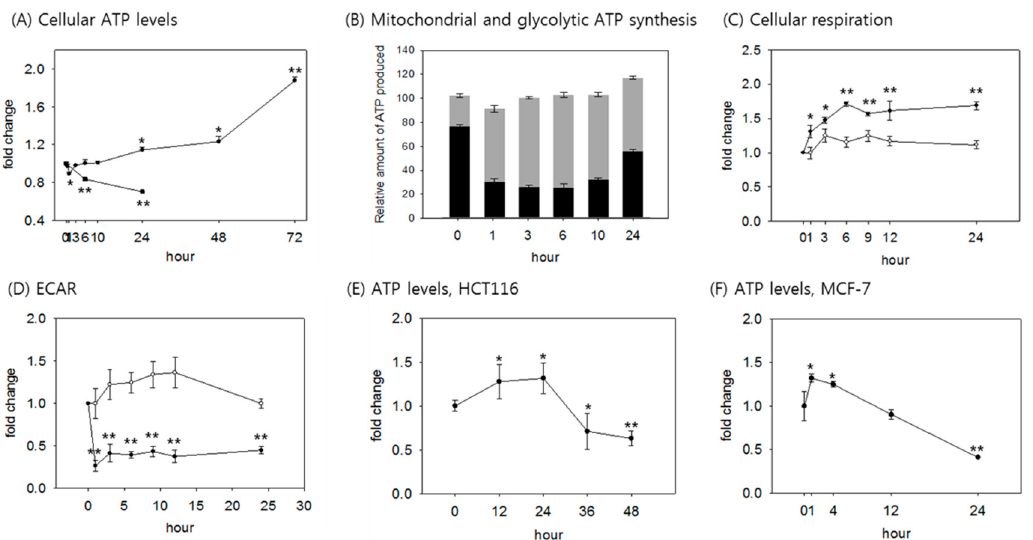
Figure 1. Increase in cellular ATP level majorly through enhanced mitochondrial ATP production in glucose-deprived cells. ( A ) Human fibroblasts were cultivated in glucose-free (- ● -) or serum-free (- ■ -) medium for the indicated time, and harvested for ATP measurement. For determination of ATP levels, at least two biological repeats were carried out; ( B ) changes in glycolytic and mitochondrial ATP productions were measured at the indicated time points. For the inhibition of OXPHOS, cells were treated with 1 µ M antimycin A and 1 µ M rotenone for the last hour of glucose withdrawal. Glycolytic ATP was determined by the measurement of ATP level in cells treated with OXPHOS inhibitor. Mitochondrial ATP production was calculated by the subtraction of glycolytic ATP from total ATP level. Changes in the total ATP level and the portions of the glycolytic (black) and mitochondrial (grey) ATP production are plotted with total ATP level, with 0 time-point cells presented as 100%; ( C , D ) fibroblasts were cultivated in medium lacking glucose and incubated on an XF24 culture plate for 24 h. Oxygen consumption and extracellular acidification were measured using an XF24 analyzer. (- ○ -) and (- ● -) show the values in cells incubated with normal medium and glucose-free medium, respectively. Values of total oxygen consumption or extracellular acidification rate were measured three times. (E, F) HCT116 or MCF7 cells were incubated without glucose for the indicated times, and cellular total ATP was measured. ATP levels were determined in at least two biological repeats. Values are presented as mean ± s.d. * p < 0.05; ** p < 0.01 by ANOVA.